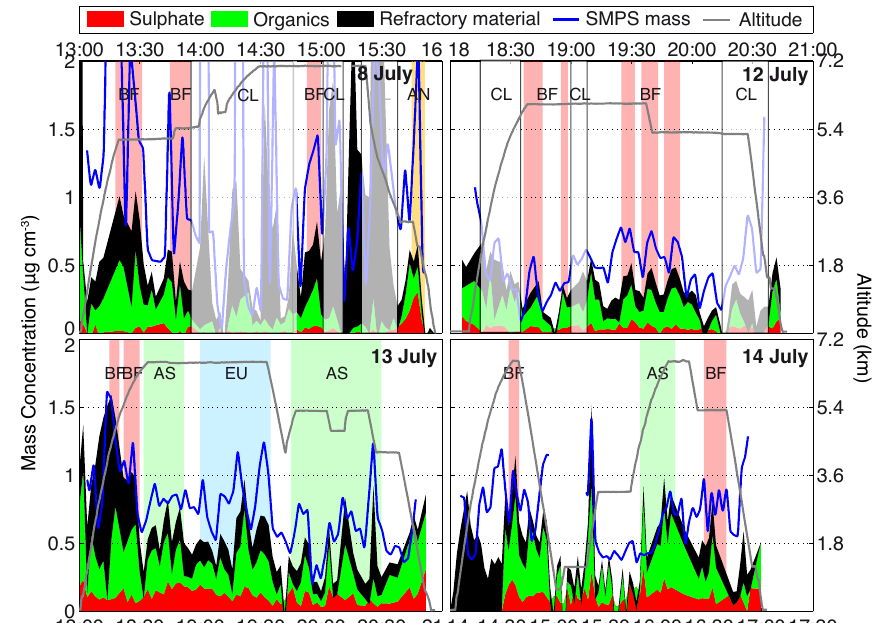
Fig. 5. Stacked aerosol mass concentrations in µgm − 3 for sulphate (red), organics (green), and refractory material (black). Air mass origins determined with FLEXPART integrated-column PES, FPES and source apportionment are noted with AN for North-American anthropogenic emissions, BF for Canadian boreal forest fires, AS for Asia and EU for Europe, while cloud presence is indicated with “CL”. The blue line represents the estimated mass of particulate material at ambient temperature calculated from SMPS aerosol volume size distributions and a density of 1.7gcm − 3